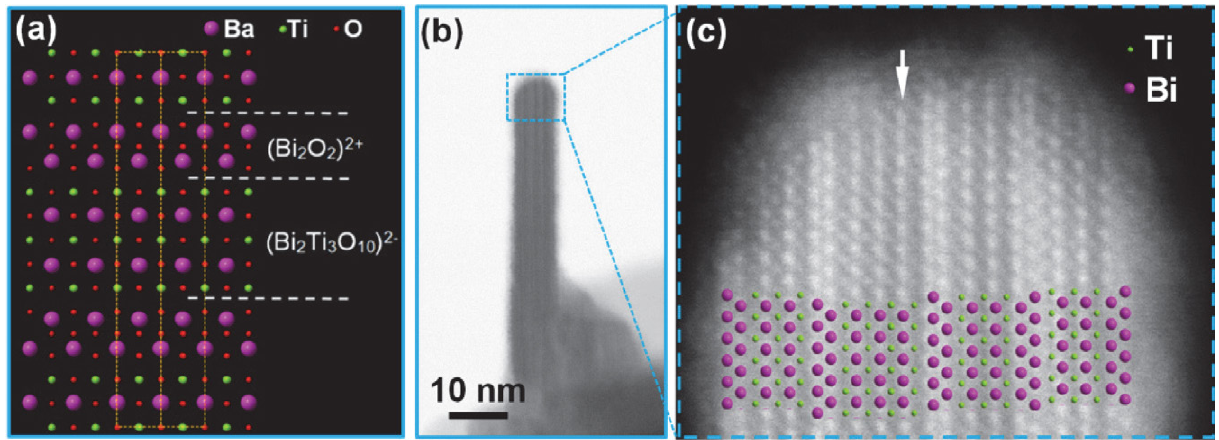
Figure 7. Schematic representation of the magnetoplumbite structure (a), and BF (b) and HAADF (c) STEM images of BIT NPL oriented along [110] direction of the pseudo-tetragonal Aurivillius structure (b). The projected structural models are superimposed over the image (c) to illustrate the positions of the Bi 3+ and Ti 4+ ions. The arrow marks a defected perovskite block ( Adapted from the publication by D. Makovec, N. Križaj, S. Gyergyek, CrystEngComm 2022, 24, 3972 – 398, with permission from The Royal Society of Chemistry. 52